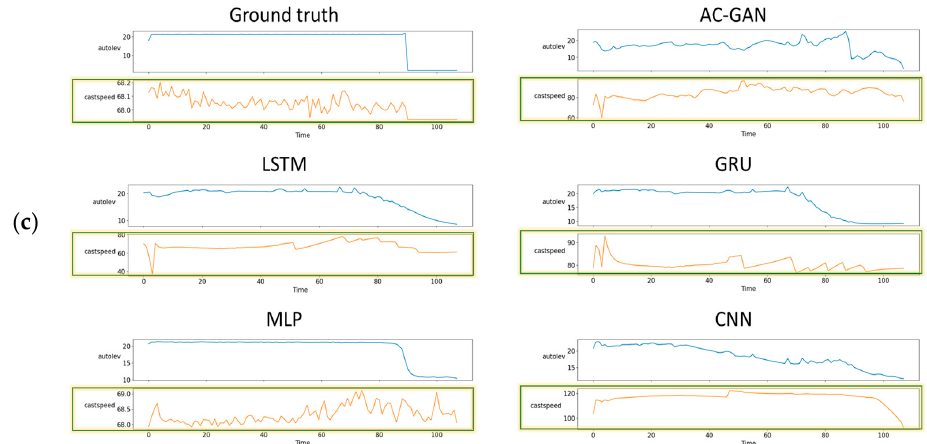
Figure 15. Visual comparison of casting process results: ( a ) input product type p1, ( b ) input product type p3, ( c ) input product type p6.